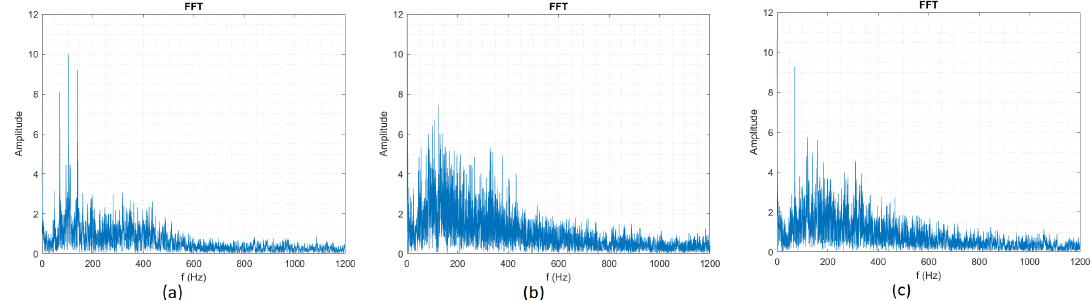
Figure 3. ( a ) Fast Fourier Transform (FFT) signal for Circle. ( b ) FFT signal for Square. ( c ) FFT signal for